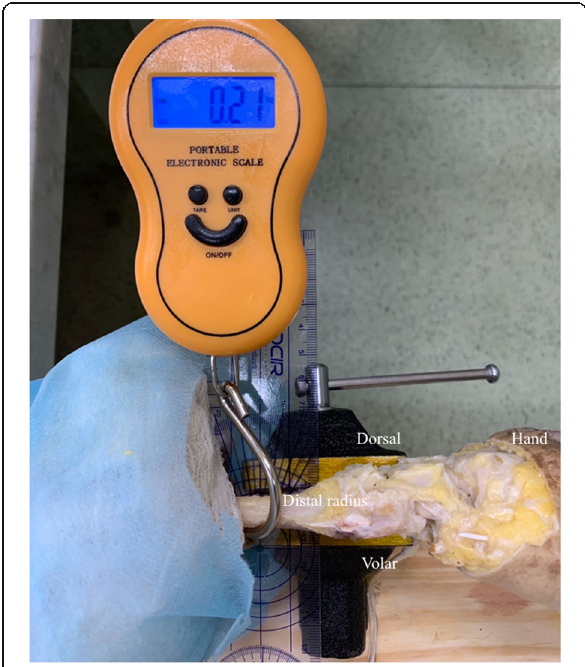
Fig. 5 Dynamometer evaluating dorsal radius